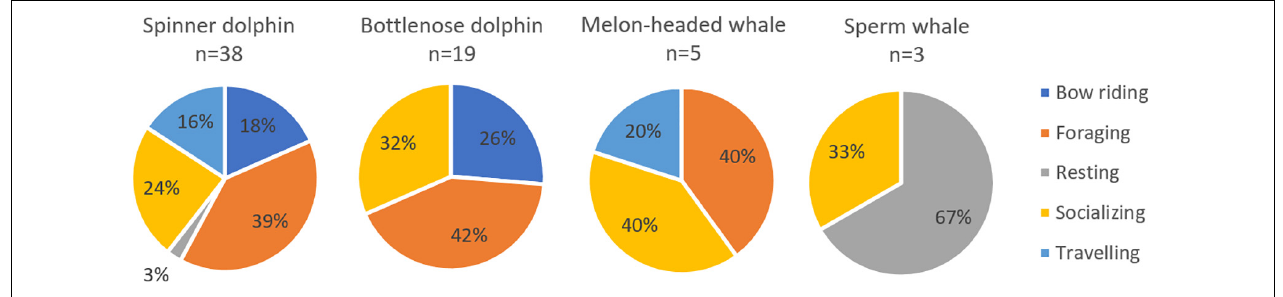
FIGURE 6 | Relative occurrence of each behavior category for four most abundant